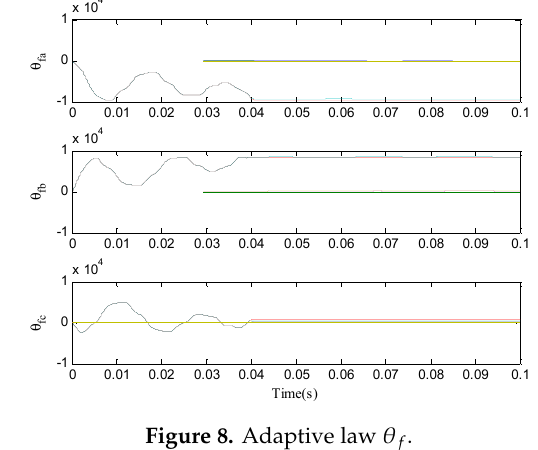
Figure 7. Compensation current tracking error.